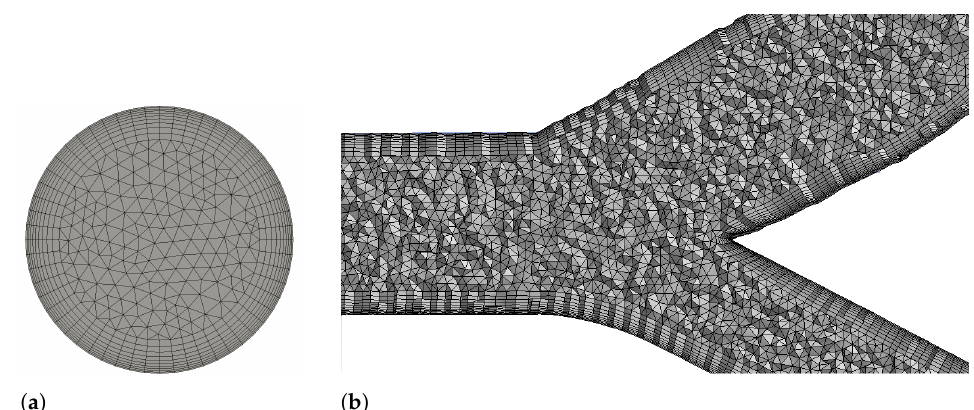
Figure 2. Computational mesh at the ( a ) inlet, and ( b ) inside of the carotid